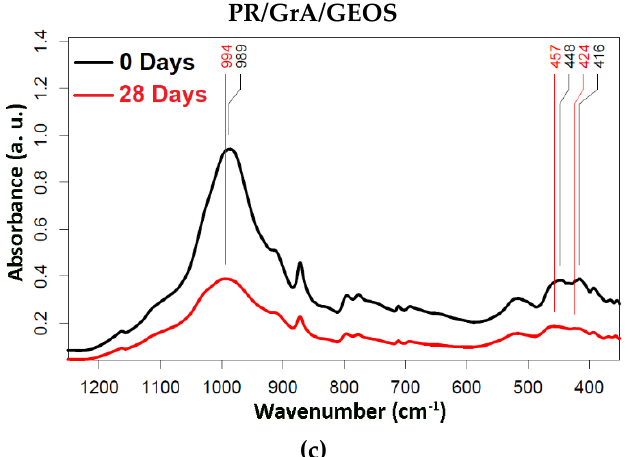
Figure 11. Details of the FT-IR spectra of PR/PeA/GEOS ( a ), PR/OlA/GEOS ( b ), and PR/GrA/GEOS ( c ) samples in the 370 – 1250 cm −1 spectral range. Lines show the positions of Si-O-T banding and stretching vibrational mode bands. After 60 days of treatment for PR/PeA/GEOS and after 28 days for PR/OlA/GEOS and PR/GrA/GEOS, a shift in the Si-O-T bands to higher wavenumbers (cm −1 ) was seen. In each graph, absorbance is reported in arbitrary units (a.u.).